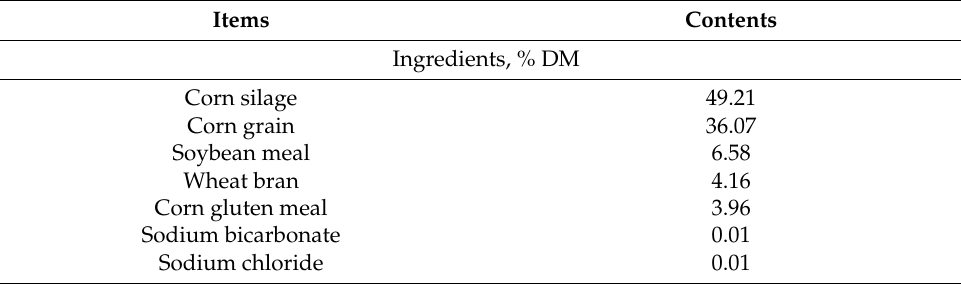
Table 1. Ingredients and nutritional composition of the basal